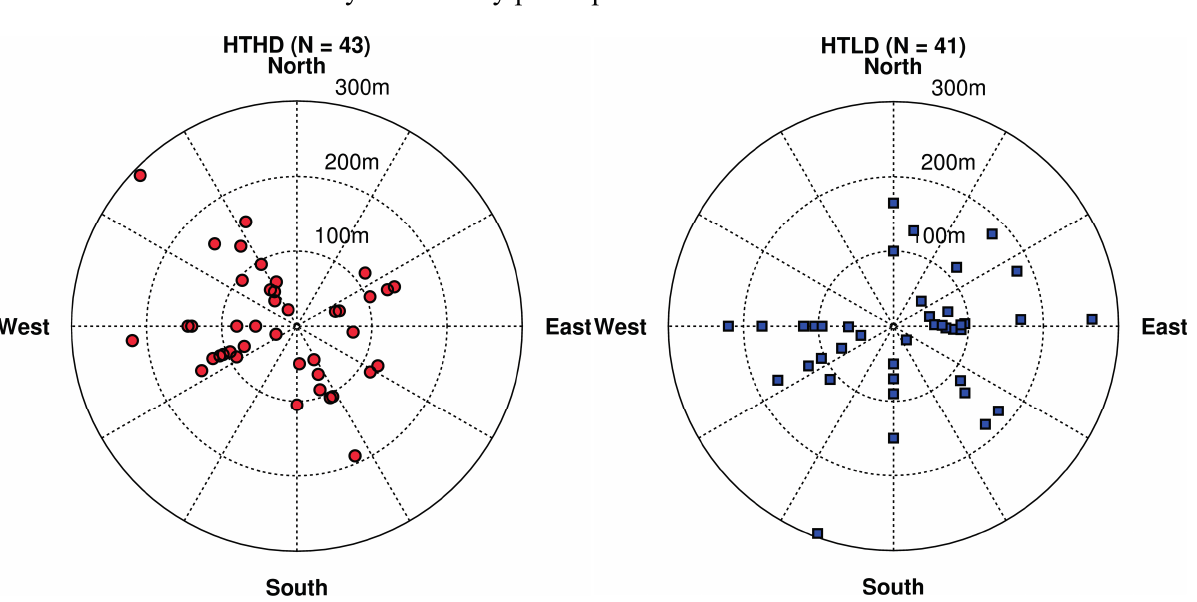
Figure 8. Locations of study participants’ homes with respect to two types of roadways: high traffic and high fraction of diesel vehicles (left panel), and high traffic and low fraction of diesel vehicles (right panel). Radial distances represent the perpendicular distance from the roadway to the study participants’ home